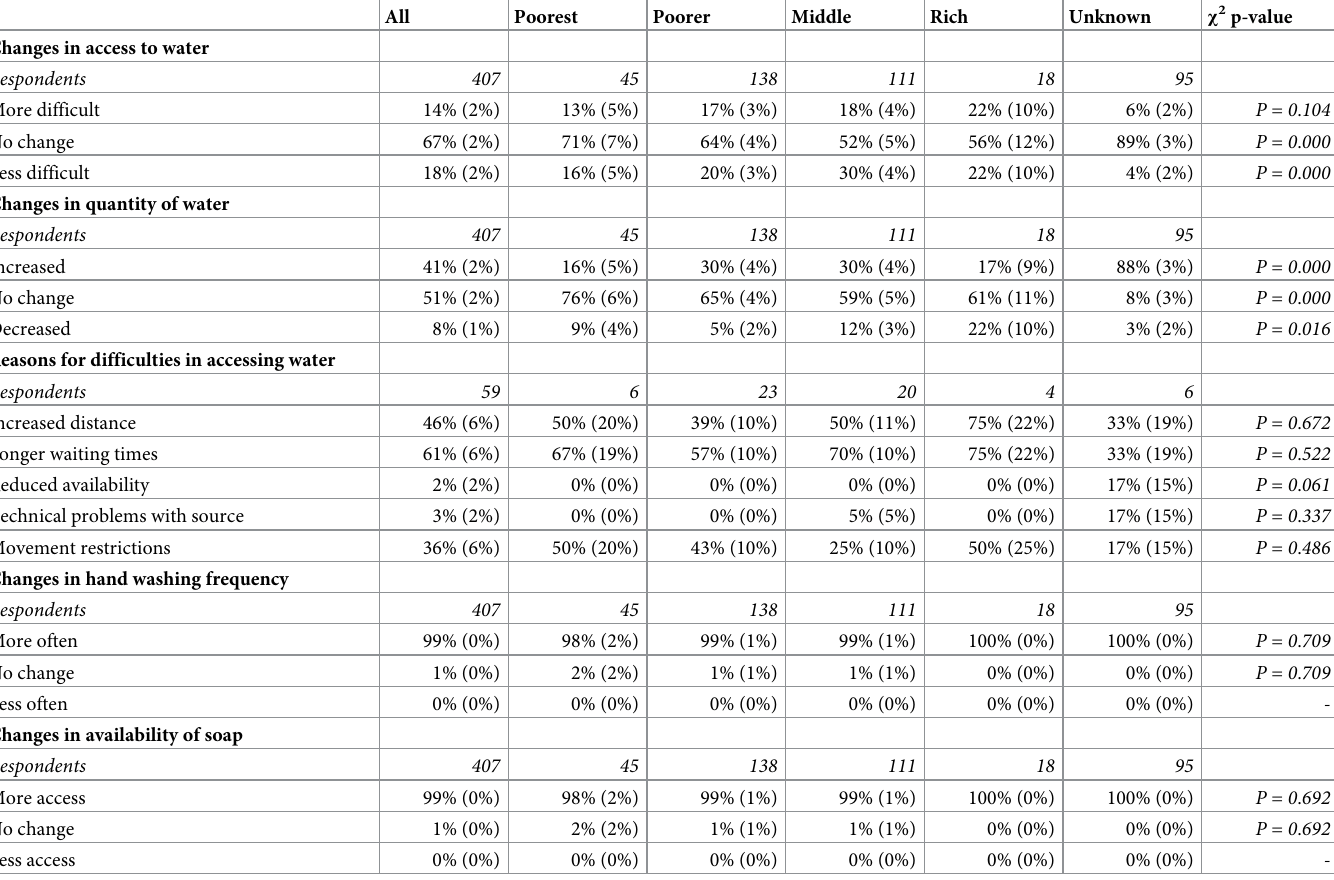
Table 6. Perceived changes in access to water, soap, hand washing frequency and reasons for difficulties in accessing water. All Poorest Poorer Middle Rich Unknown χ 2